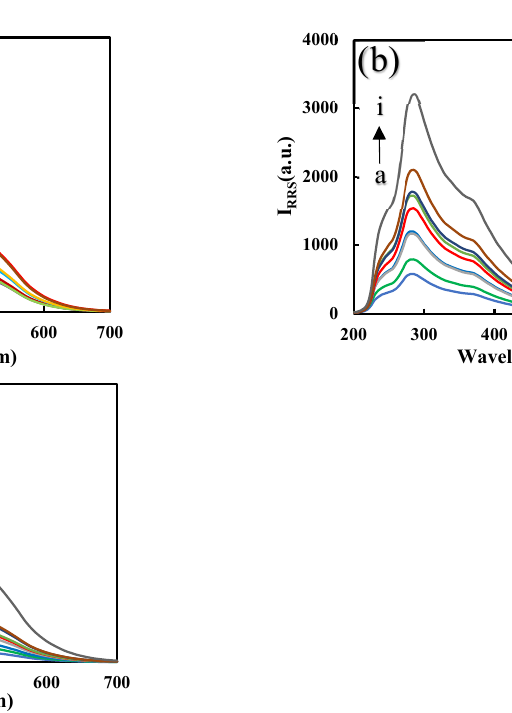
Figure 5. SERS spectra of the analysis system. ( a ) a to h: (0, 0.067, 0.13, 0.2, 0.27, 0.33, 0.67, 1) nM Pb 2+ + HM + Apt + PN 3 + AgNO 3 + SF + VBB; ( b ) a to i: (0, 0.05, 0.1, 0.2, 0.3, 0.4, 0.5, 1, 2) nM Pb 2+ + PN 3 + Apt + HM + AgNO 3 + SF; ( c ) a to i: (0, 0.05, 0.1, 0.2, 0.3, 0.4, 0.5, 1, 2) nM Pb 2+ + PN Fer3 + Apt + HM + AgNO 3 + SF.